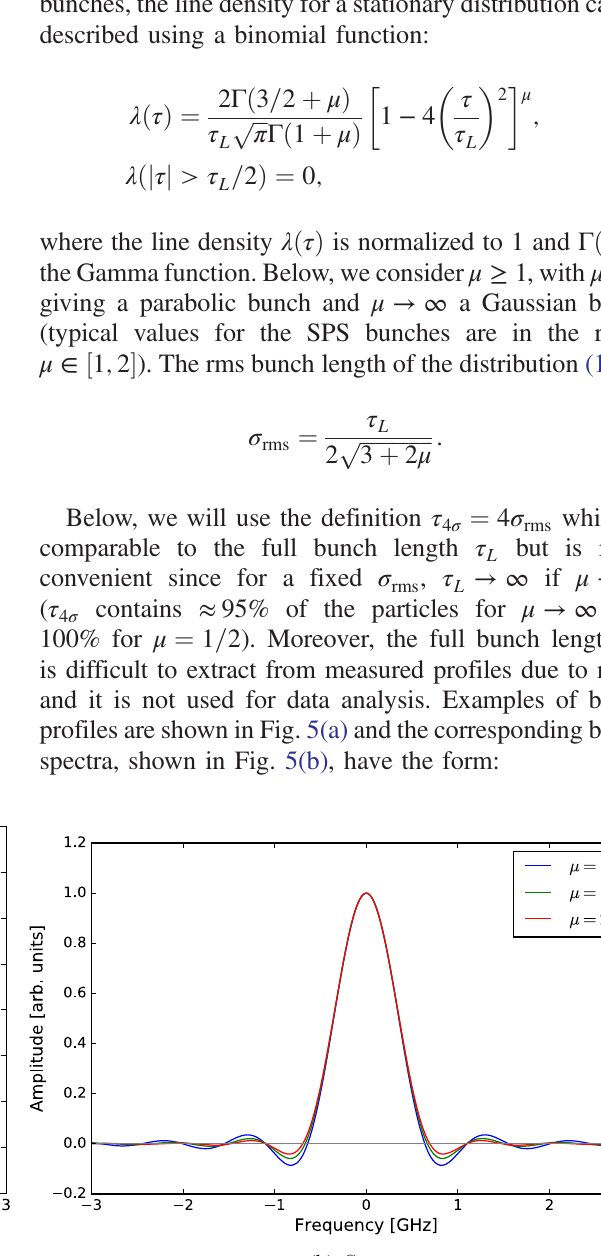
FIG. 5. Line densities (left) and corresponding spectra (right) for different μ values and the same rms bunch length σ indicates the bunch length τ 4 σ